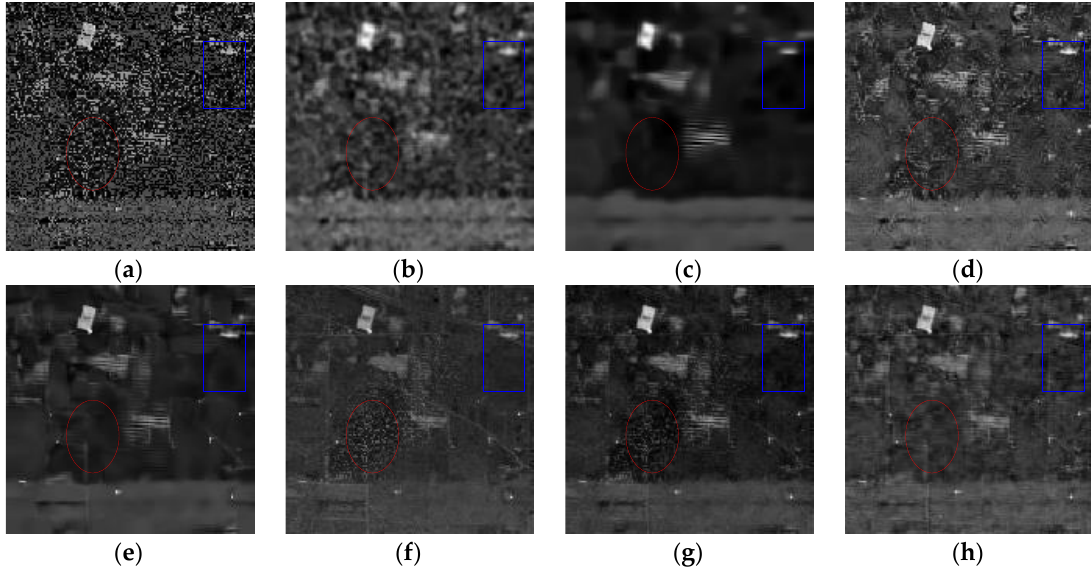
Figure 20. Restored results in Indian Pines image: ( a ) Original band 1; ( b ) KSVD; ( c ) BM3D;